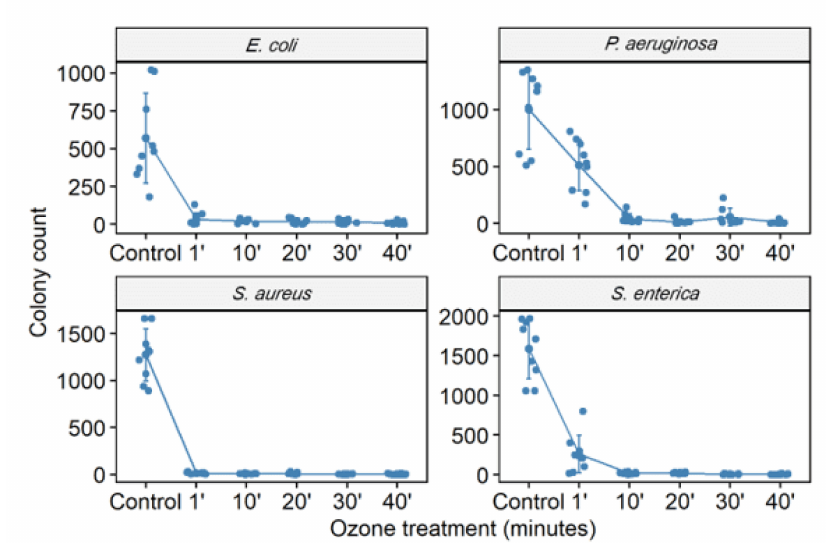
Figure 1. The number of colony-forming units (CFU) in different bacterial strains ( S. aureus (ATCC 6538), P. aeruginosa (ATCC 15442), S. enterica (ATCC 10708), and E. coli (ATCC 25922)) was counted. CFU counting was performed in the control group (no treatment) and bacterial suspensions (10 5 CFU/mL) after exposure to ozone for 1, 10, 20, 30, and 40 min.